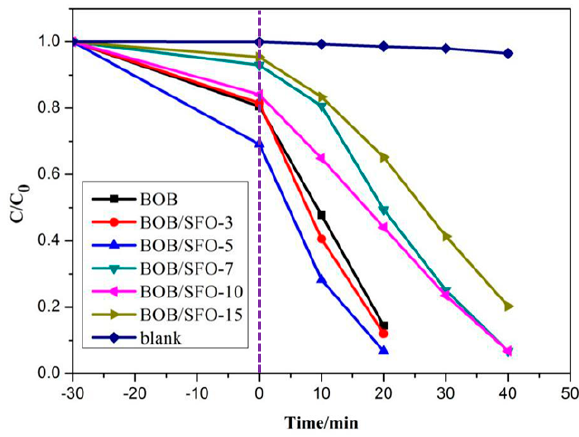
Figure 6. Photocatalytic degradation rate in pure BOB and composites of different amounts of SFO.